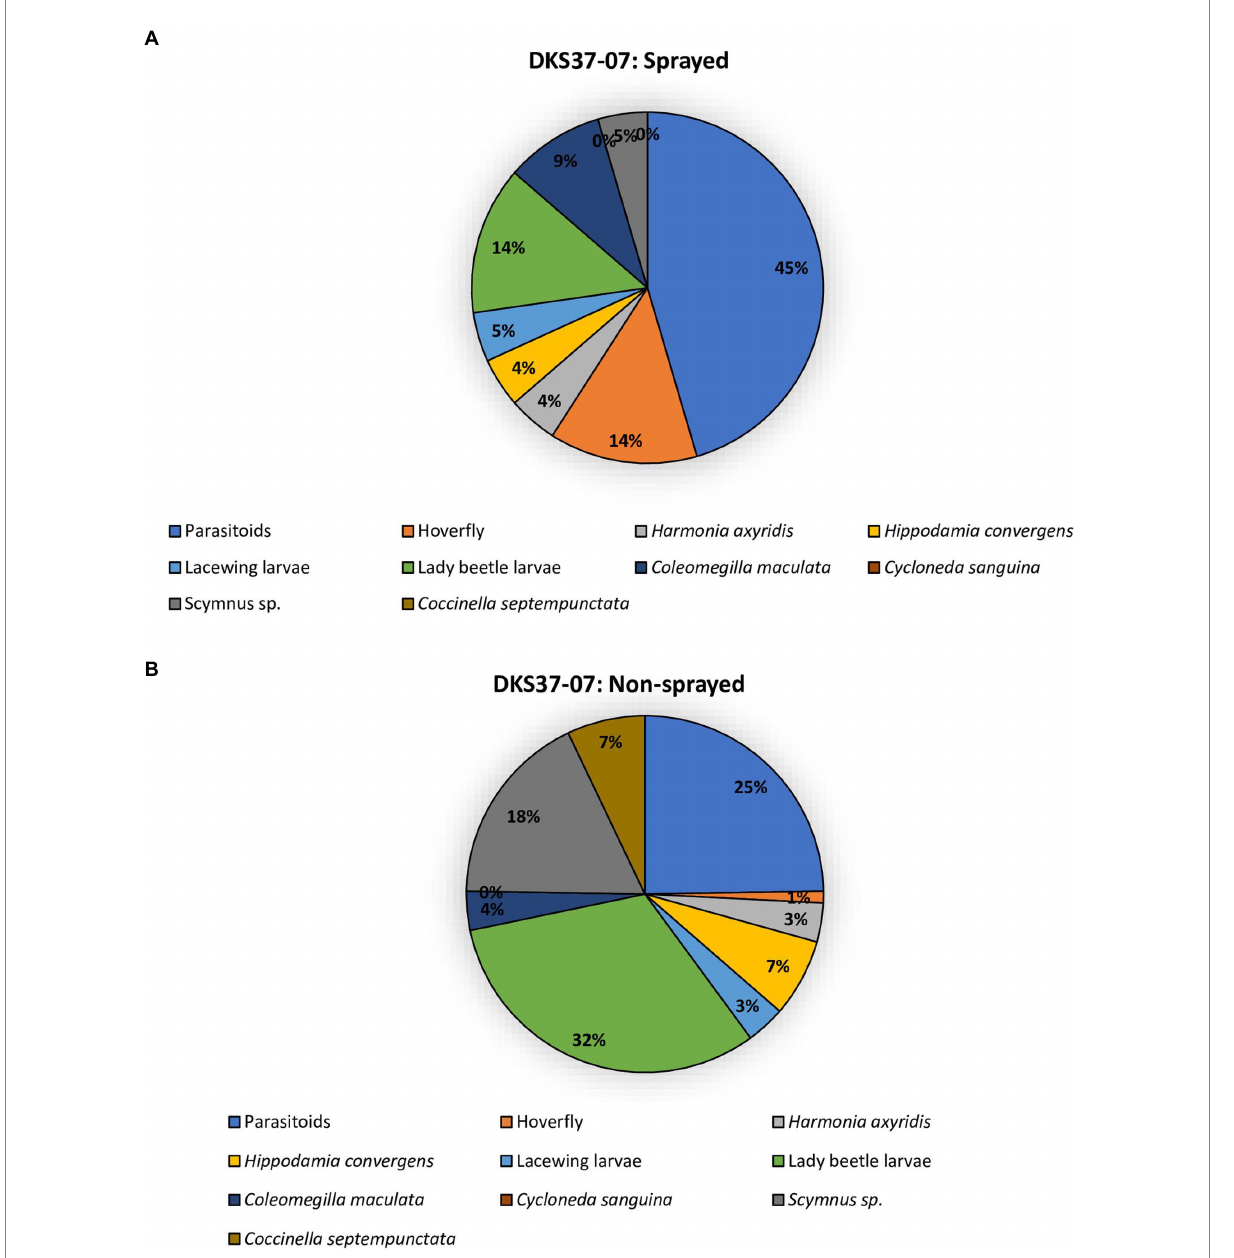
FIGURE 5 Percentage of natural enemies observed on resistant sorghum cultivar (DKS37-07) that was flupyradifurone sprayed (A) or non-sprayed (B) using the pooled data from all